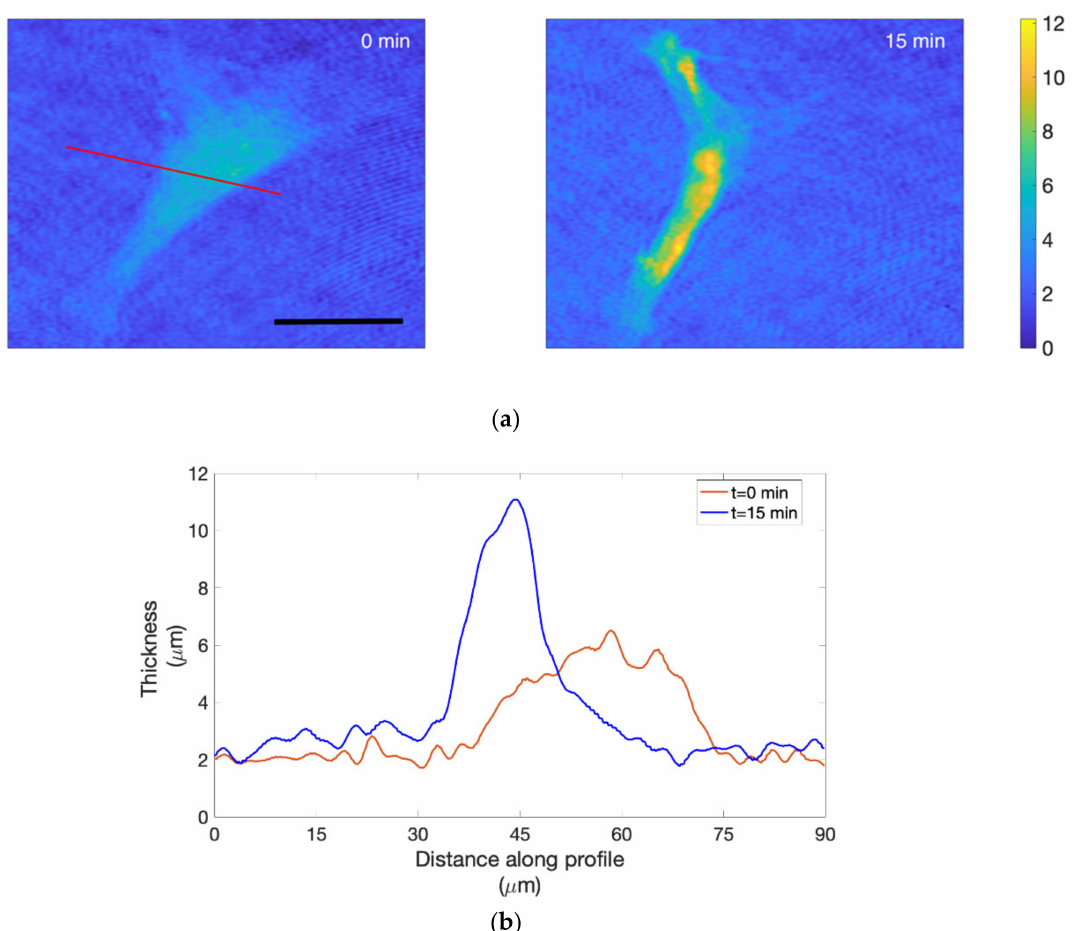
Figure 9. Thickness map ( µ m) and cell-thickness profiles: ( a ) thickness map ( µ m) of reconstructed holograms extracted from the time lapses at 0 and 15 min. Scale bar: 50 µ m; ( b ) cell-thickness profiles relative to t = 0 min (orange line) and t = 15 min (blue line) were plotted along the red line across the